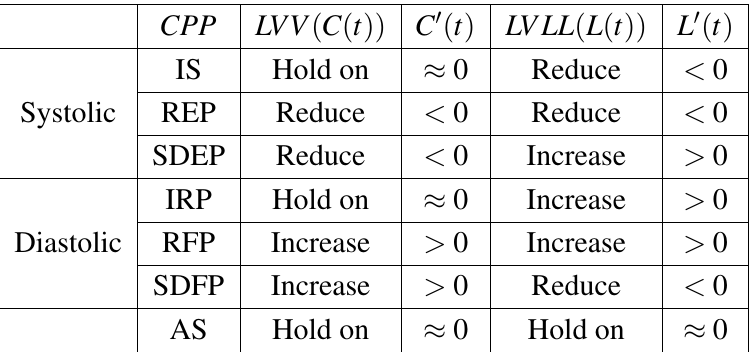
Table 1. LVV and LVLL Features of Each